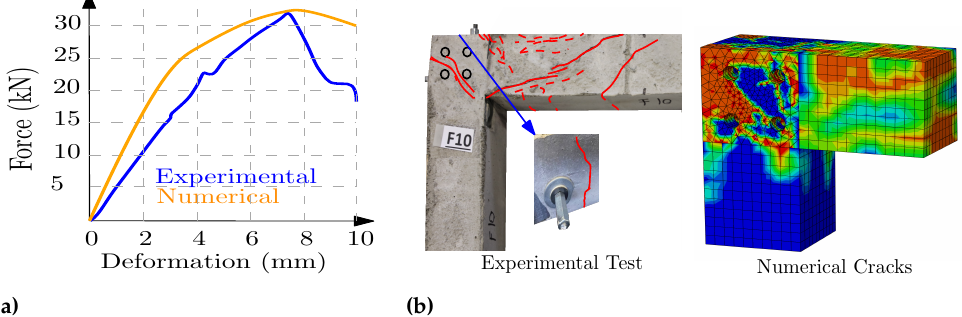
Figure 20. F8, ( a ) Force–deformation, ( b ) experimental cracking and numerical cracking